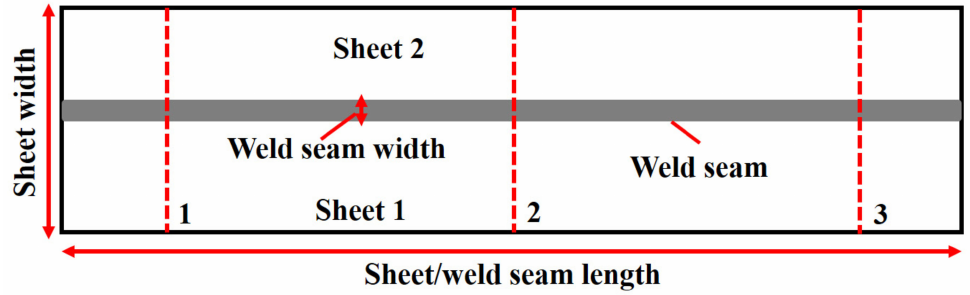
Figure 4. X-ray analyses’ schematic on the weld seam at various locations: (1) at the beginning, (2) in the center, and (3) at the end of the